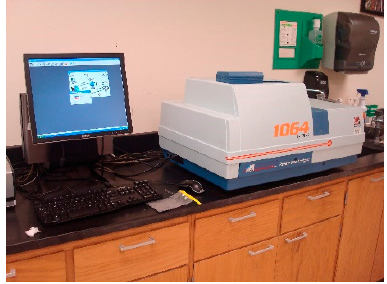
Figure 1. Particle size analyzer.